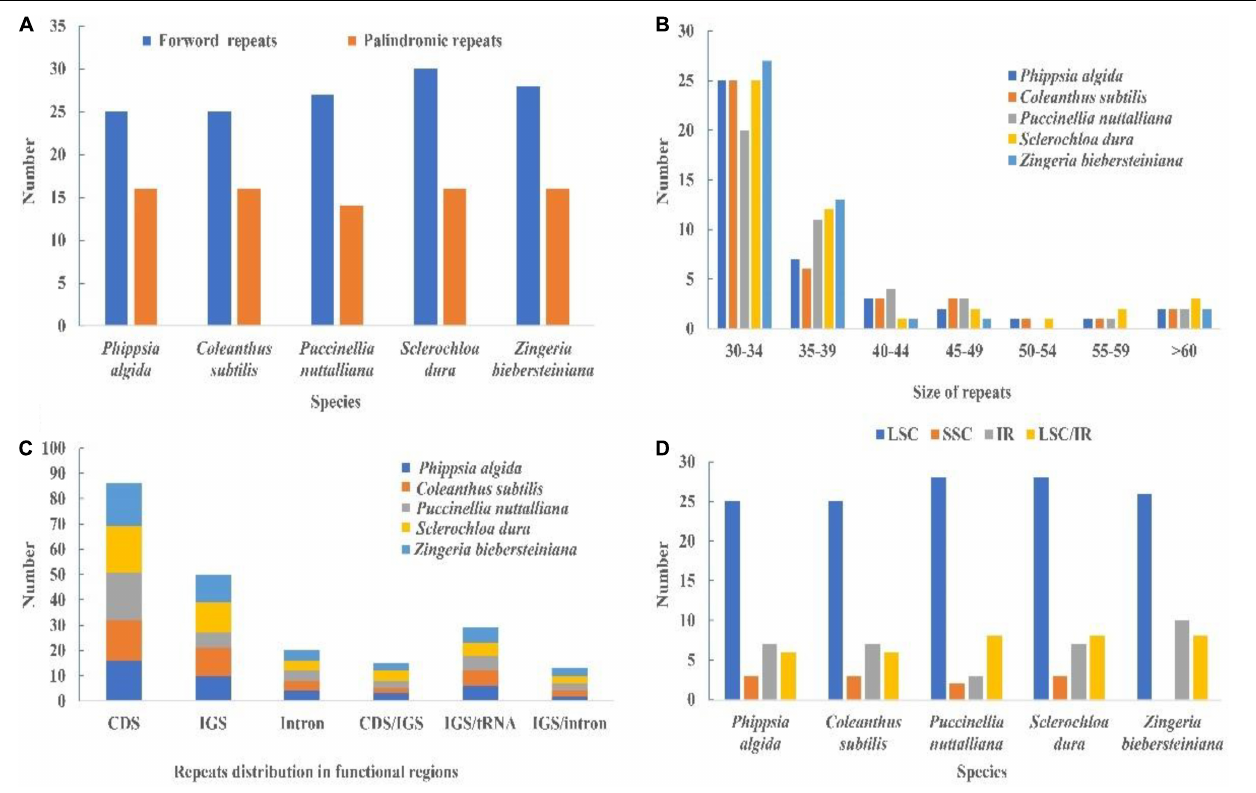
FIGURE 7 | (A) Type of repeats in the whole chloroplast genomes of C . subtilis and its related species. (B) Size of repeats in the chloroplast genome of C . subtilis and its related species. (C) Distribution of repeats in functional regions of the plastid genome. (D) Distribution of repeats in regions of the chloroplast genomes. IR, inverted repeat; LSC, large single copy; SSC, small single copy; LSC/IR show those repeats for which one copy of the repeat exists in one region and a second copy exists in another region. CDS, protein-coding sequence; IGS, intergenic spacer